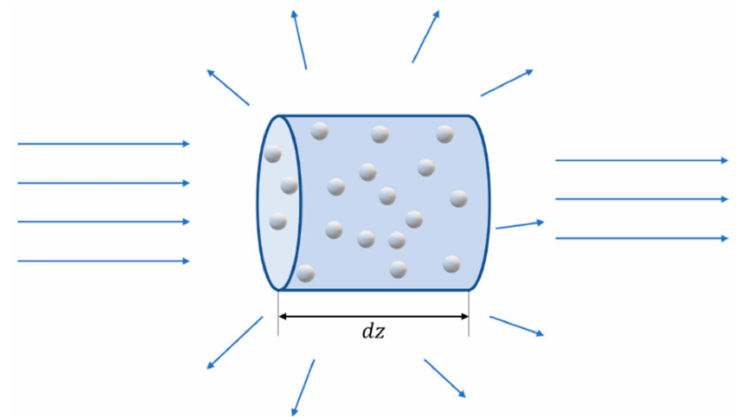
Figure 14. Illustrative example of Mie scattering. Adapted from